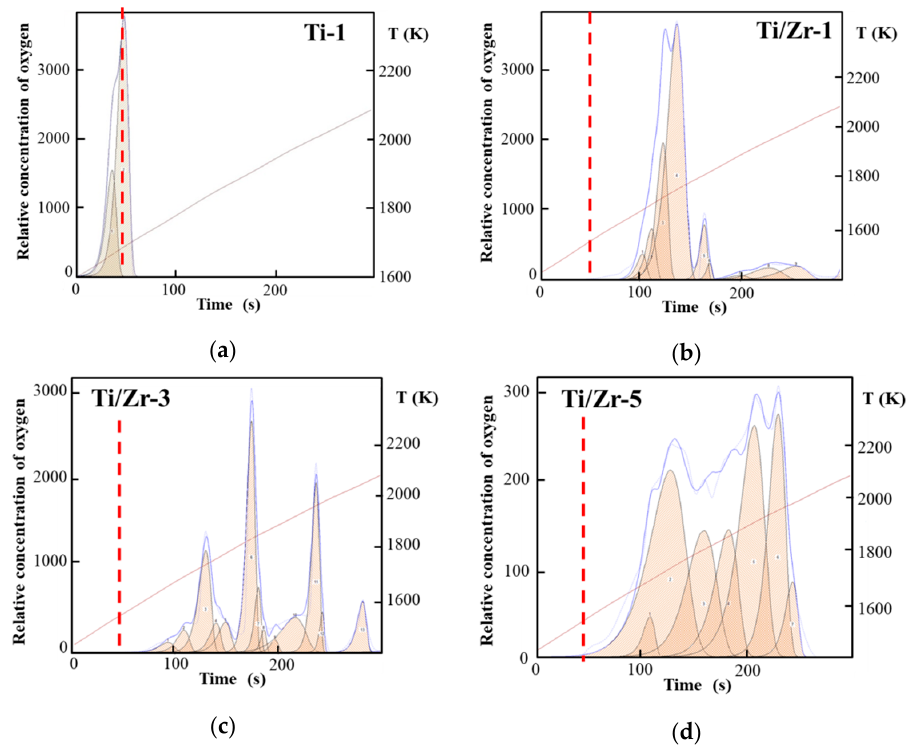
Figure 4. Typical time charts obtained by fractional gas analysis (FGA) measurements of oxide inclusions in metal specimens from the Ti and Ti/Zr experiments: ( a ) Ti-1, ( b ) Ti/Zr-1, ( c ) Ti/Zr-3 and ( d ) Ti/Zr-5. Table 4. Classification of main oxide inclusions in the Ti/Zr experiments by using FGA measurements.